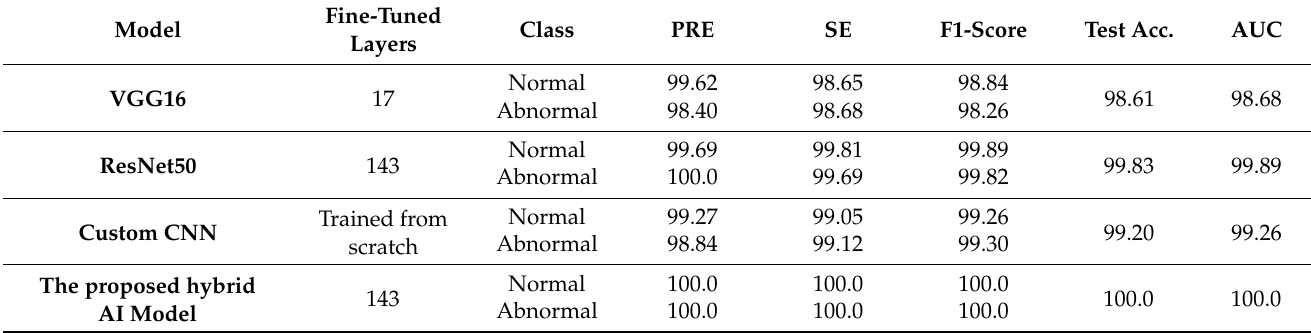
Table 8. Scenario A evaluation results (%) using Dataset 1 as an average over five-fold tests.